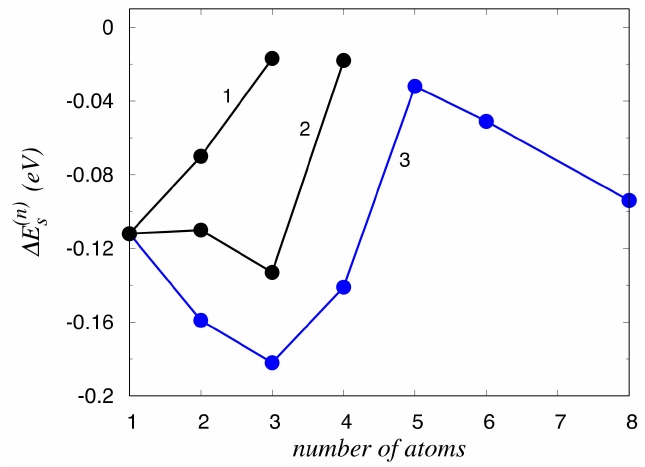
( n ) Figure 2. Segregation energy ∆ E s as a function of the number of atoms in Zn segregation for various possible fillings of atomic positions. The curves 1,2 and 3 correspond to the sequence of filling nodes (1)–(5)–(2), 3–( − 3)–(1)–(2), and ( − 3)–(2)–(1)–(3)–( − 2)–(4)–(5)–( − 5),